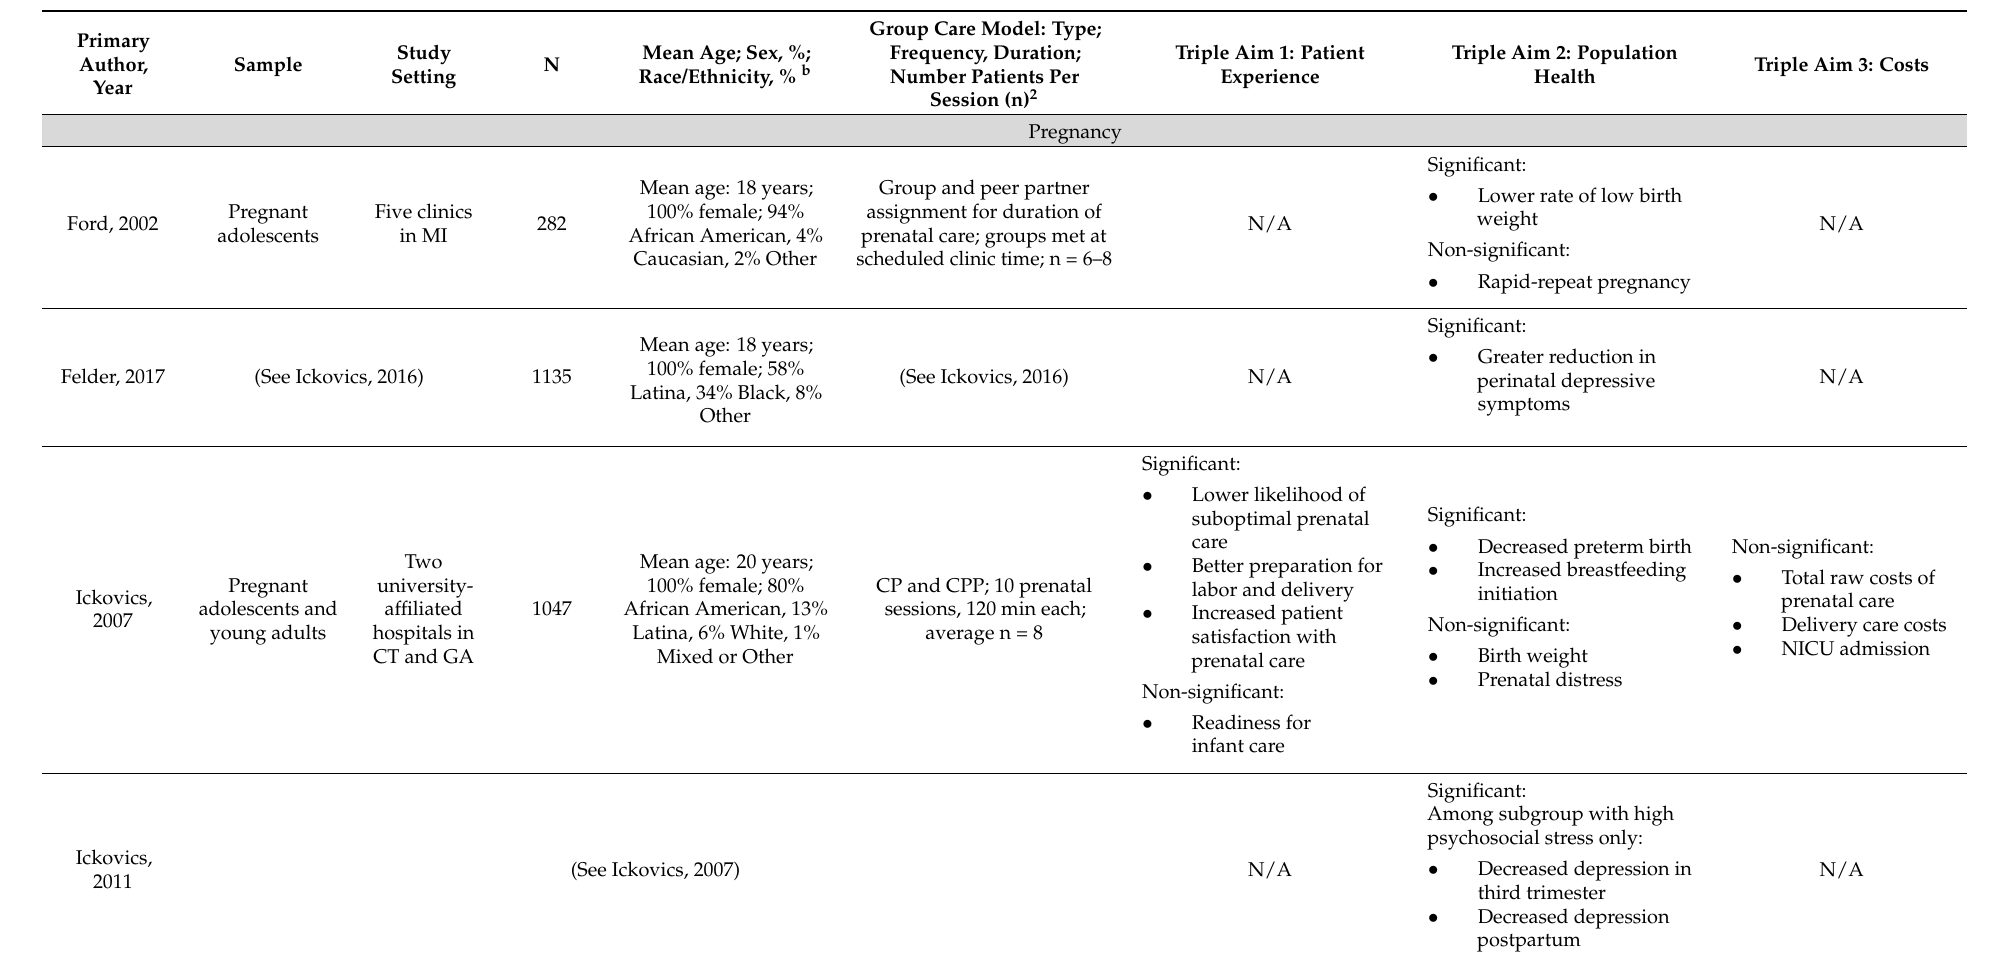
Table 1. Characteristics of studies included in systematic review a